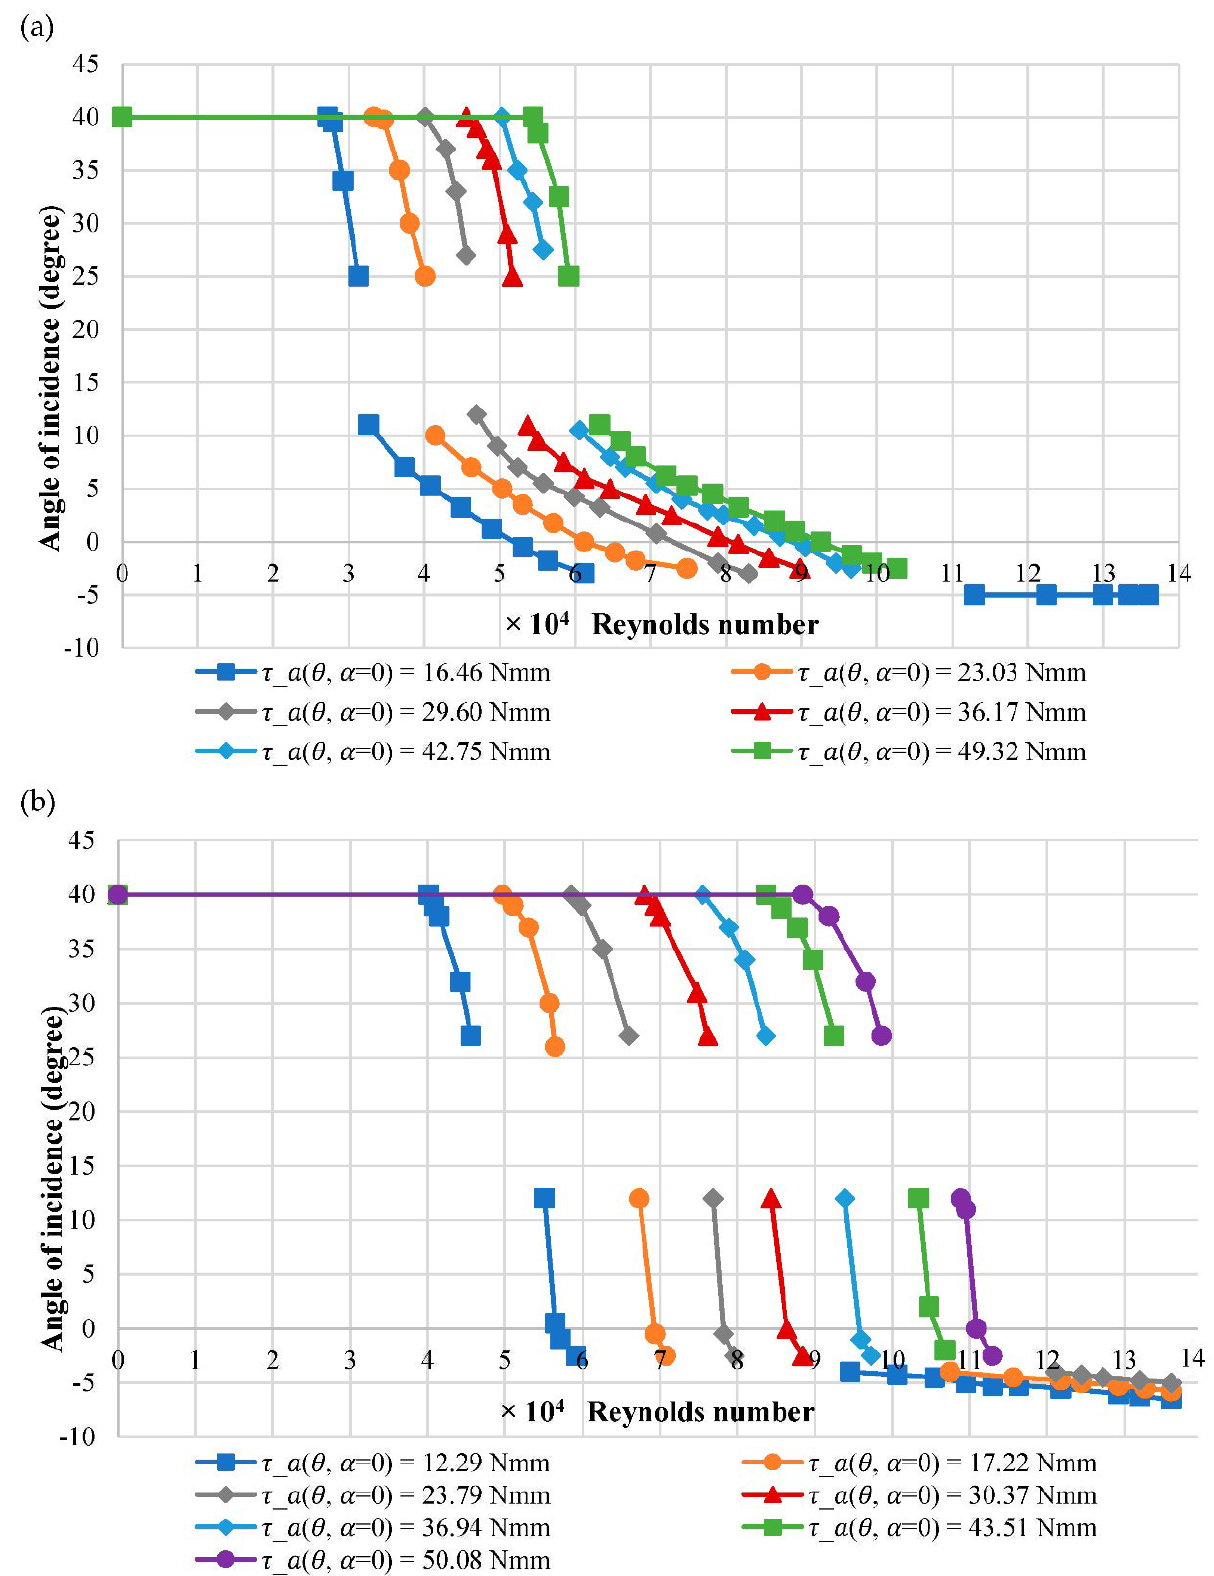
Figure 7. Response of the angle of incidence against flow velocity for ( a ) MP1 and ( b ) MP2 of NACA